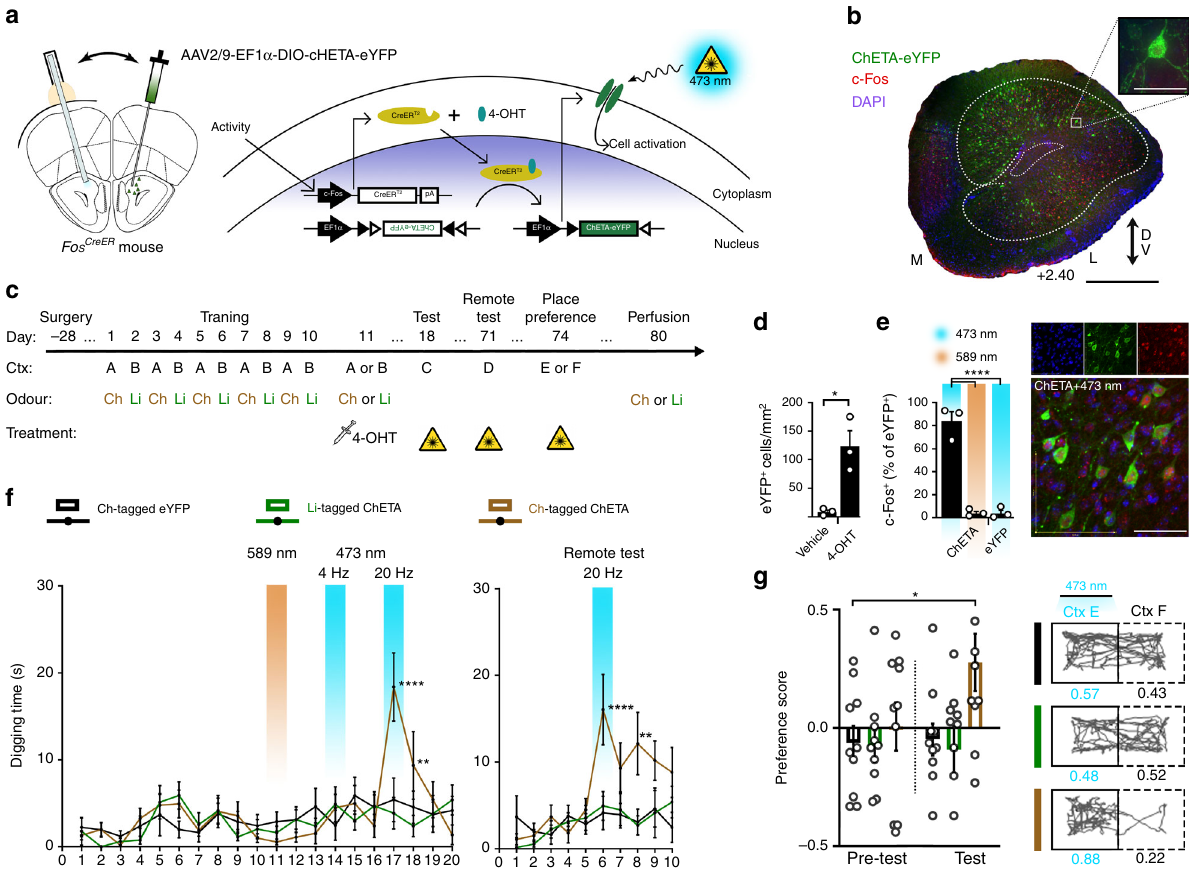
Fig. 2 Arti fi cially expressing unique odour engrams. a Method for activity-dependent labelling of AON neurons with photoreceptive ChETA-eYFP for subsequent cellular activation. b Representative coronal section of the AON expressing ChETA-eYFP (green) and c-Fos (red); DAPI (blue). Scale bars represents 500 µ m (black) or 50 µ m (white). Medial (M); Lateral (L); Dorsal/Ventral (DV). Similar results were observed in all mice independently analysed. c Protocol for tagging and examining the behavioural expression of two unique odour engrams. Chocolate (Ch); Limonene (Li). d Injections of 4- OHT induces AAV-mediated gene expression of ChETA-eYFP [each group, n = 3 mice, independent-samples t -test, t (4) = 4.184, * P = 0.0139]. e Left: percentage of ChETA-eYFP or eYFP-only labelled neurons which express c-Fos following light illumination [each group, n = 3 mice, one-way ANOVA, F (2, 6) = 79.67, **** P < 0.0001]. Right: representative confocal image of ChETA-eYFP neurons after stimulation with 473 nm light. Scale bar represents 50 µ m. f Measurements of time spent digging 7 days (left) or 60 days (right) post-tagging [each group, n = 10 mice; 7 days (left): two-way ANOVA, main effect of group F (2, 27) = 0.6025, ns, P = 0.5547; main effect of Time F (19, 513) = 4.901, **** P < 0.0001; main effect of subjects (matching) F (27, 513) = 2.870, **** P < 0.0001; interaction F (38, 513) = 2.352, **** P < 0.0001; 60 days: two-way ANOVA, main effect of group F (2, 27) = 5.3, * P = 0.0114; main effect of Time F (9, 243) = 5.432, **** P < 0.0001; main effect of subjects (matching) F (27, 243) = 2.929, **** P < 0.0001; interaction F (18, 243) = 2.342, ** P = two-way ANOVA, main effect of group F (2, 54) = 3.727, * P = 0.0305; main effect of light F (1, 54) = 1.492, ns, P = 0.2272; interaction F (2, 54) = 1.523, ns, P